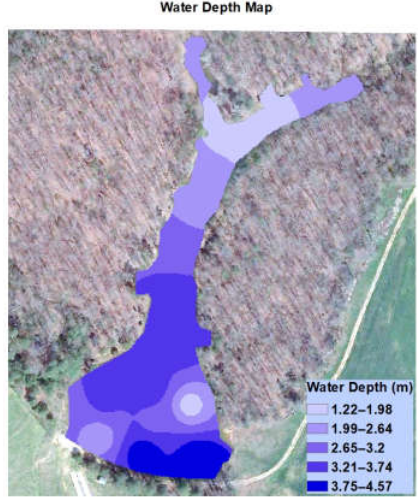
Figure 7. Spatially interpolated data from manual depth measurements.